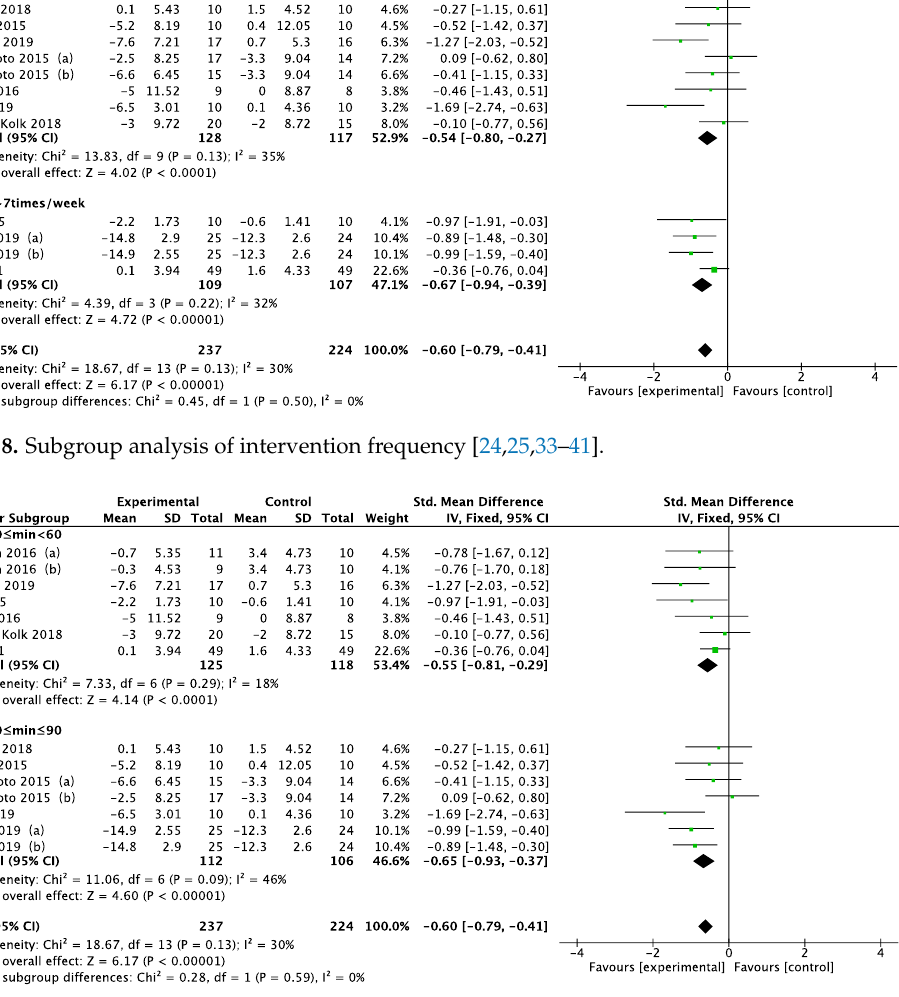
Figure 9. Subgroup analysis of intervention time [24,25,33 – 41].